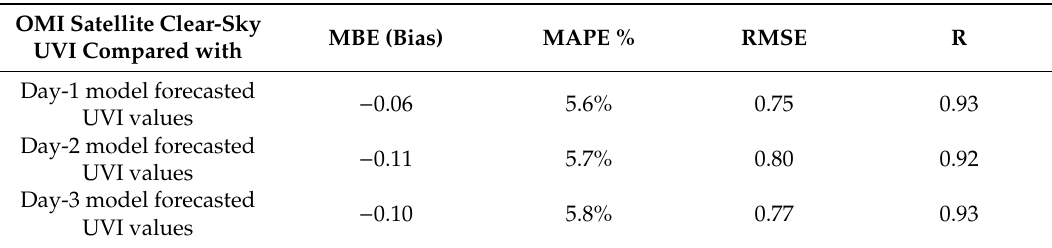
Table 2. The statistical parameters to qualify the model for prediction of daily UVI (Day-1), 1 day forecast UVI (Day-2), and 2 day forecast UVI (Day-3)